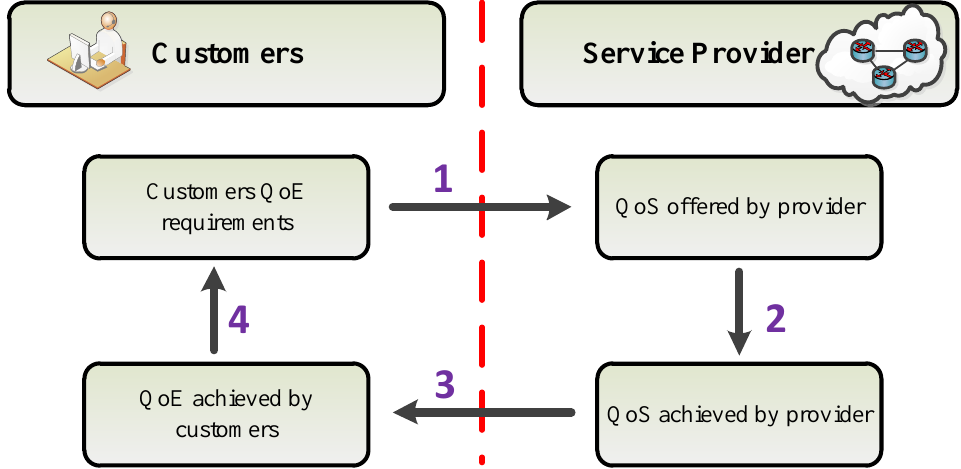
Figure 1. The correlation between the customer and provider points of view on the quality of service.